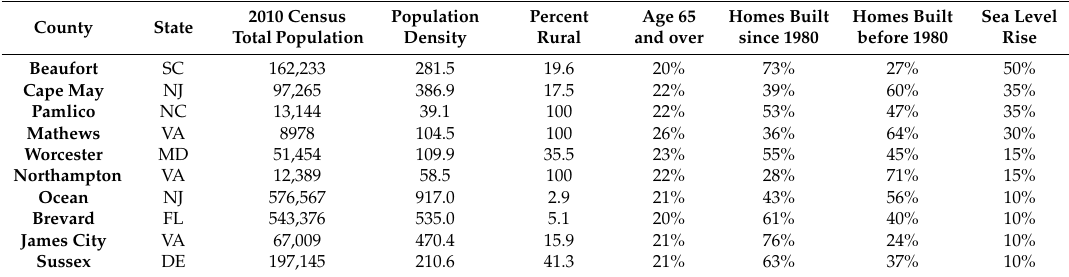
Table 1. Ten counties with the older population over 20 percent and the highest exposure to 6-foot sea level rise, including the percent of rurality and the age of